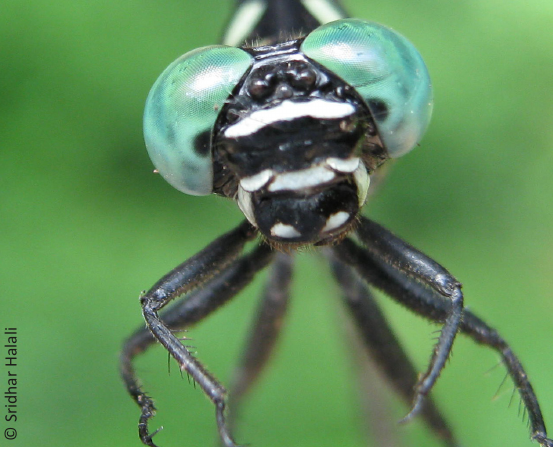
Image 2. Microgomphus souteri - Head showing mouth